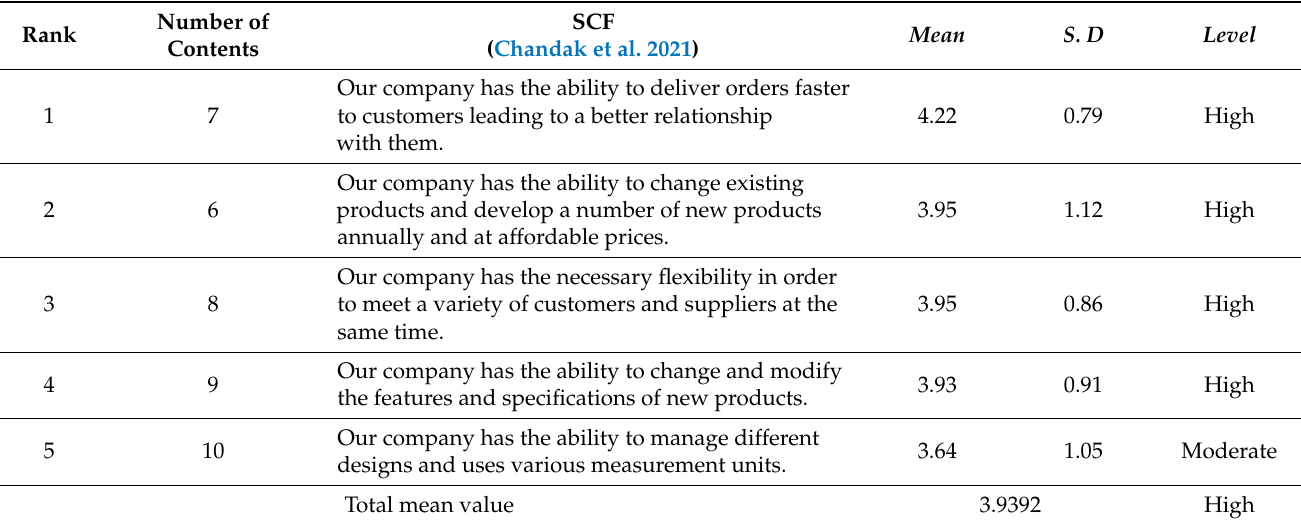
Table 3. Descriptive analysis—SCF items (N =